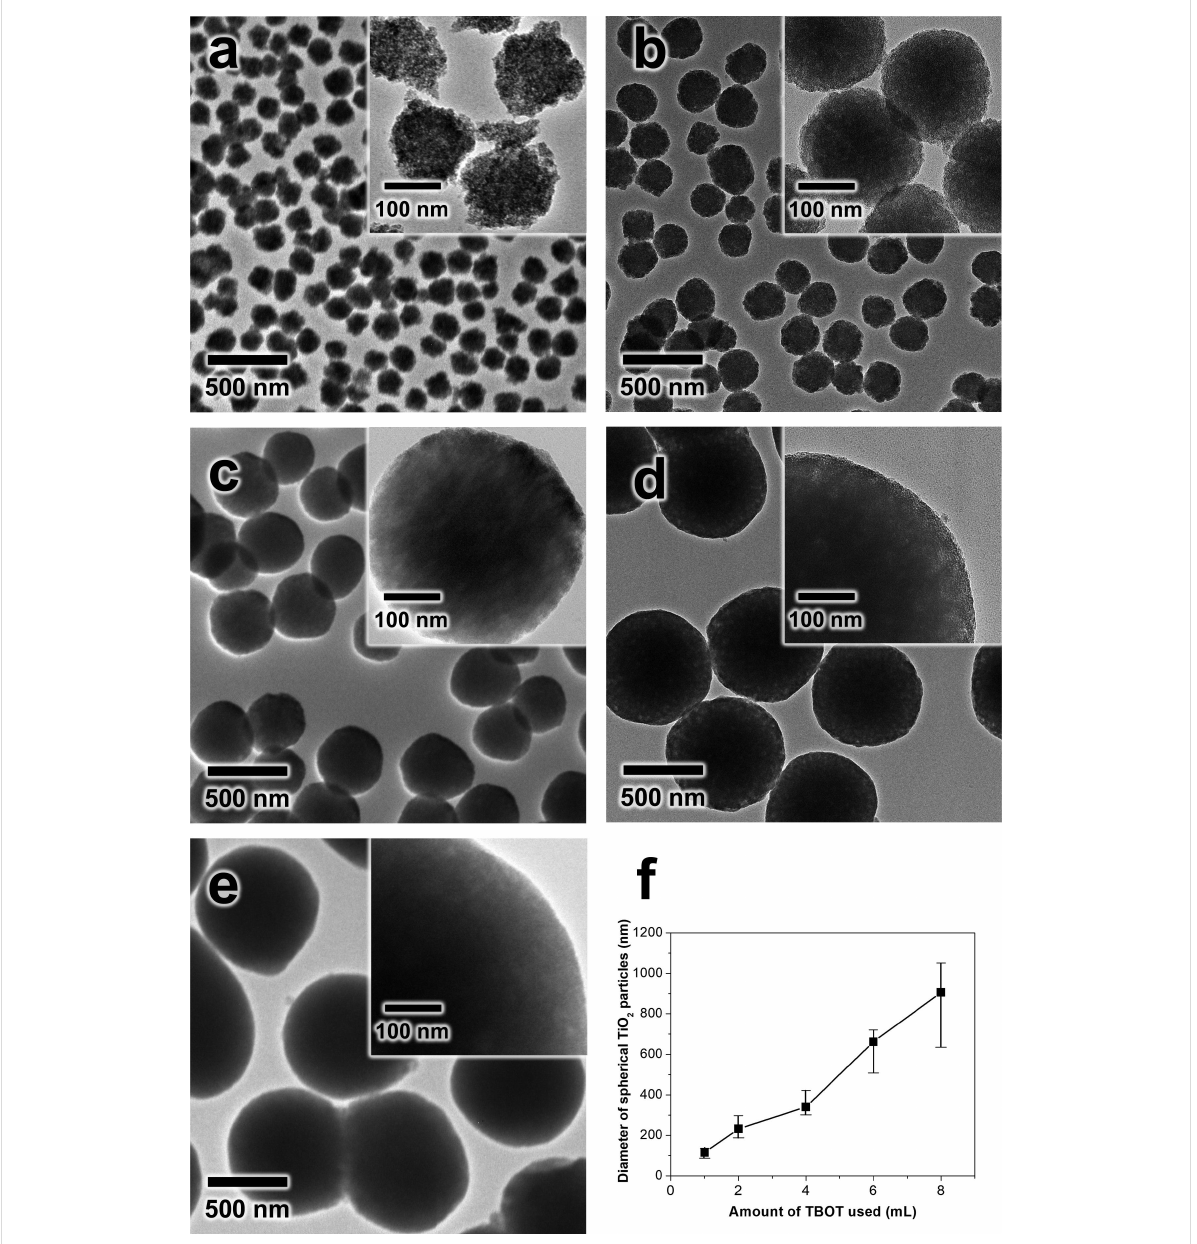
Figure 3: (a–e) TEM images of as-synthesized TiO 2 with different amounts of TBOT: (a) 1 (b) 2 (c) 4 (d) 6 and (e) 8 mL. (f) The relationship between the amount of TBOT used and the average diameter of the spherical TiO 2